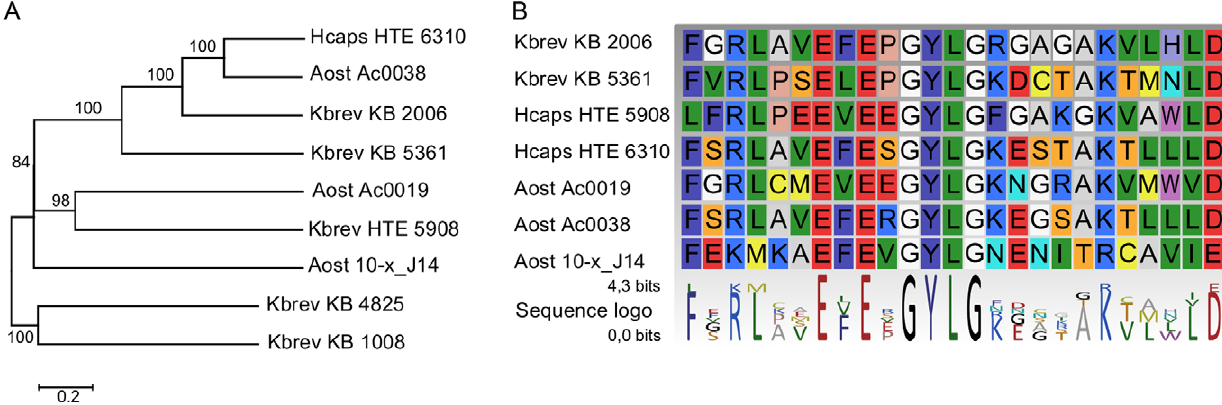
Figure 3. Phylogena and multiple alignment of the truncated N-terminal region from dinoflagellate KS. A. Maximum likelihood phylogenetic analysis of truncated N-terminal regions with 100 Bootstrap repetions. B. Multiple alignment of a highly conserved motif within the N- terminal region and the sequence logo showing the degree of sequence conservation of the respective site.